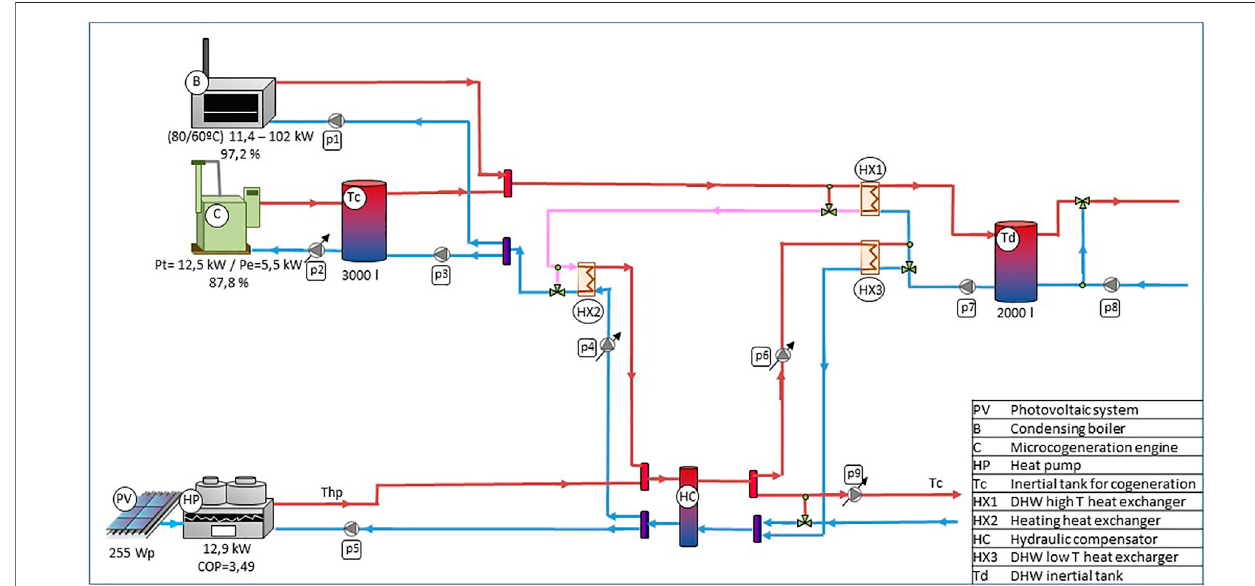
FIGURE 3 | Main equipment summary and scheme of the installation.